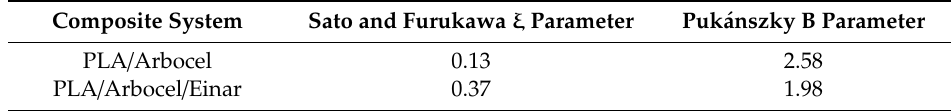
Table 4. Values of the calculated parameter correlated to the fiber / matrix adhesion according to the Sato and Furukawa and Puk á nszky models for the PLA / Arbocel composite system with and without